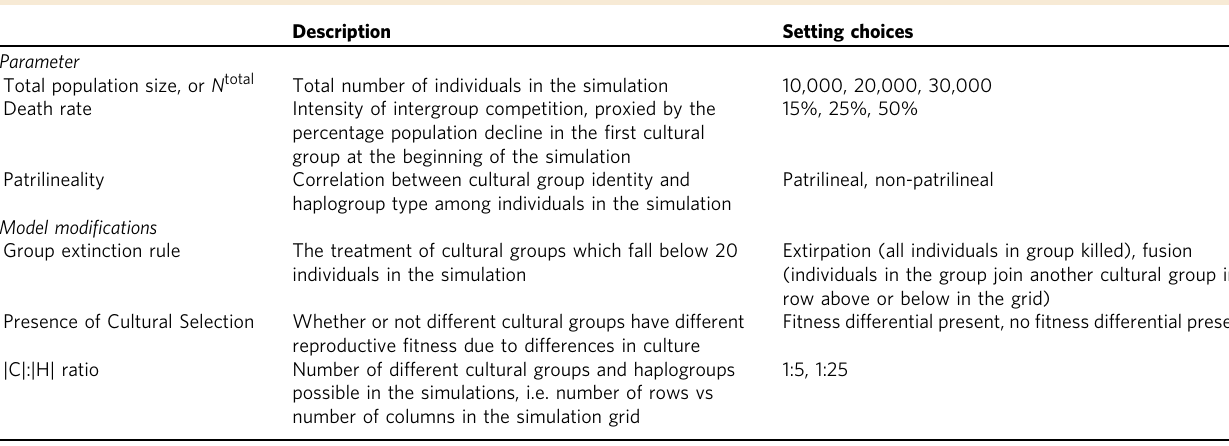
Table 1 Parameters and model choices used in the simulations a Description Setting